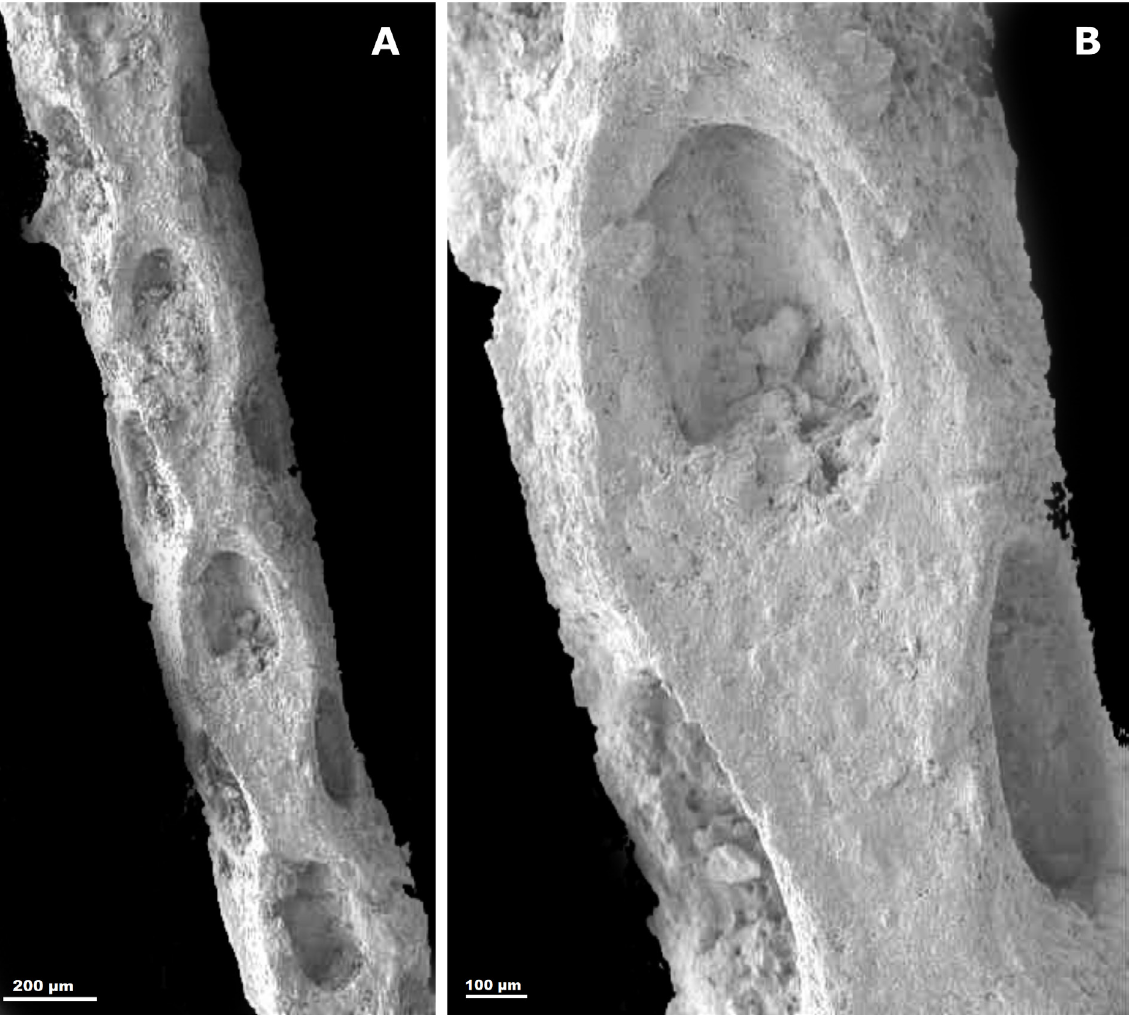
Fig. 10. ? Tretosina gen. et sp. indet. (GIS/B 0522). A . General view of the colony showing hexagonal autozooid arranged in longitudinal rows. B . Close-up of a single autozooid showing oval opesia and tuberculated